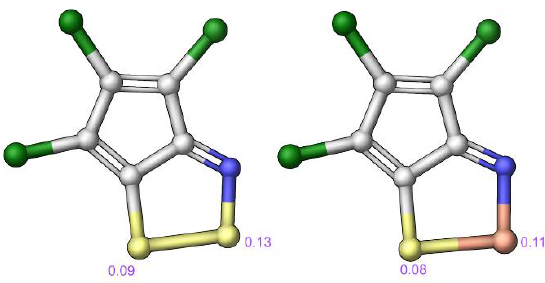
Figure 2. Fukui f-NN-LUMO indices for 10a (model for 1,2,3-dithiazoles) vs 11a (model for 1,2,3-thiaselenazoles). The atoms are colored: yellow - sulfur; bronze - selenium; blue - nitrogen; grey - carbon; green - chlorine.